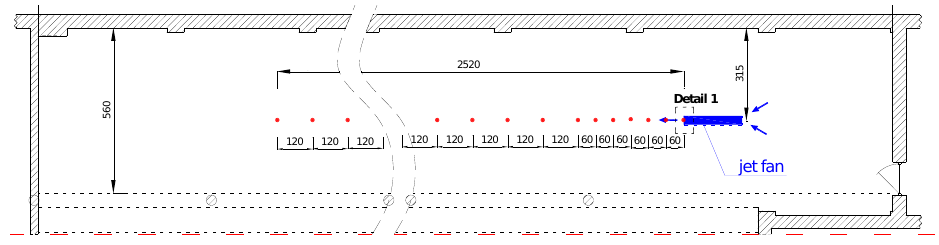
Figure 3. Photo of the test room.